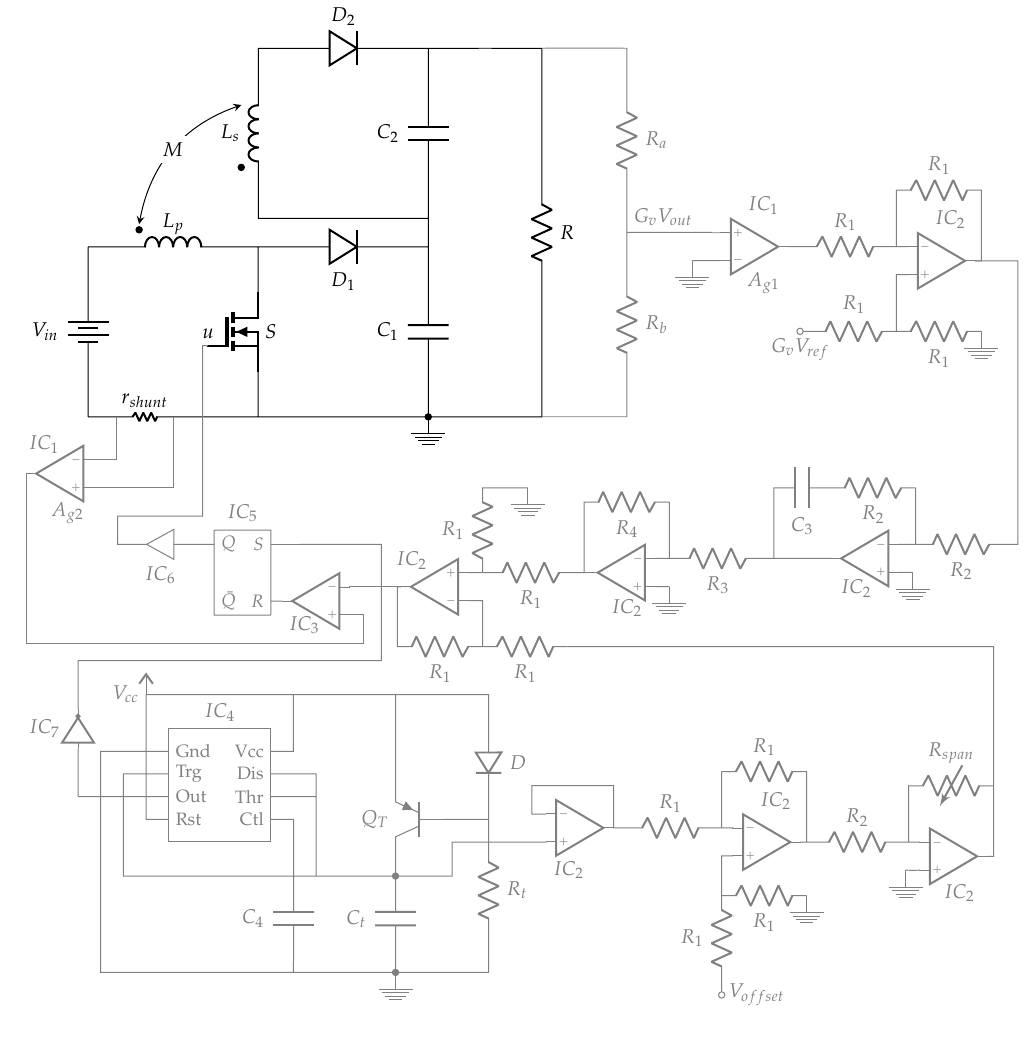
Figure 7. Experimental